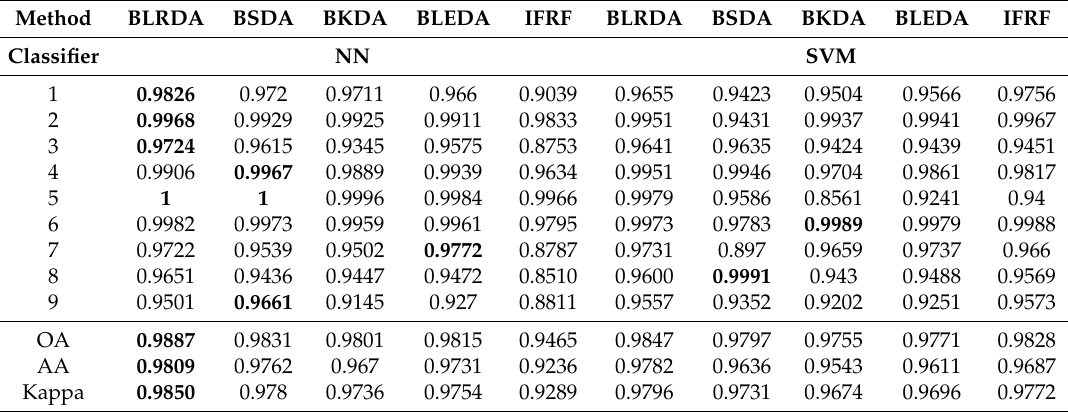
Table 3. Supervised and semi-supervised classification results for the Pavia University scene. BLRDA, Block Low-Rank Discriminant Analysis. BSDA, Block Sparse Representation Discriminant Analysis. BKDA, Block k -Nearest Neighbor Discriminant Analysis. BLEDA, Block Locally Linear Embedding Discriminant Analysis. IFRF, Image Fusion and Recursive